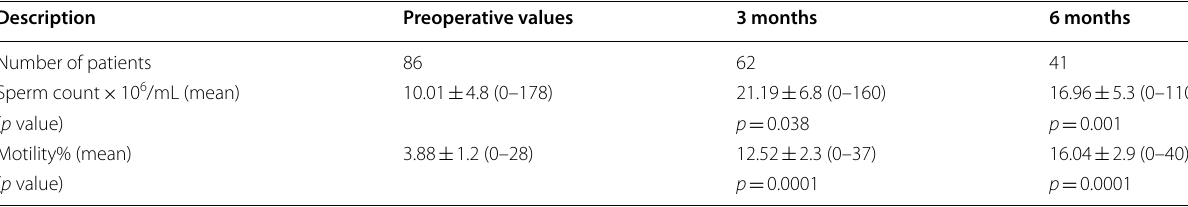
Table 1 Preoperative and postoperative comparison of semen parameters